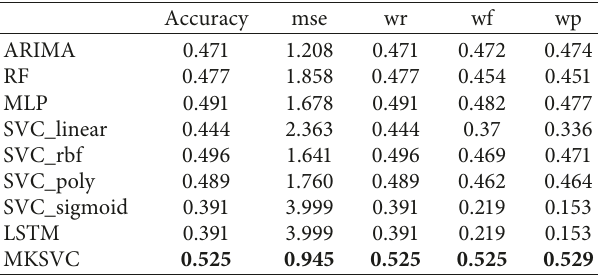
Table 13: Performance comparison for predicting the future 3 hour’s PM2.5 IAQL in Beijing.